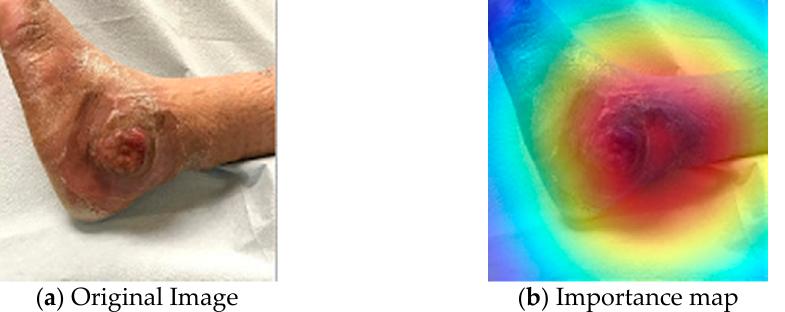
Figure 9. The probabilities of wound types. Diabetic: 29%, pressure injury: 14%, lymphovascular: 56%, surgical: 1% (Diabetic).